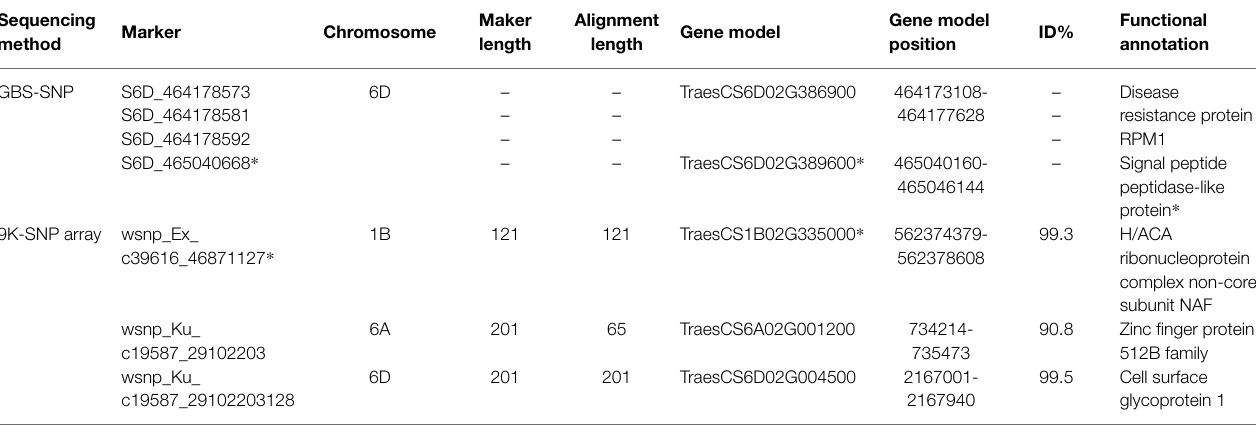
TABLE 5 | List of gene models harboring the common significant markers in Exp.S.I. and Exp.S.II. and their functional annotation. Sequencing